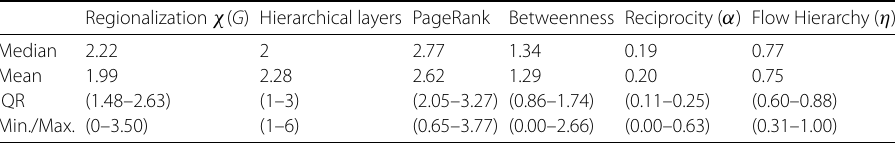
Table 2 Network Metrics by Community. ( Network measures are defined in the methods